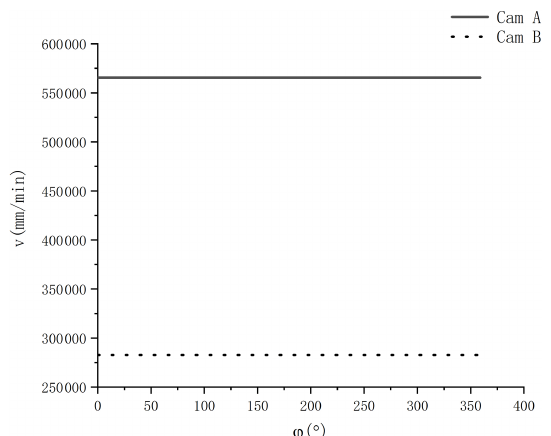
Figure 13. The velocities of the piston pump in cam A and cam